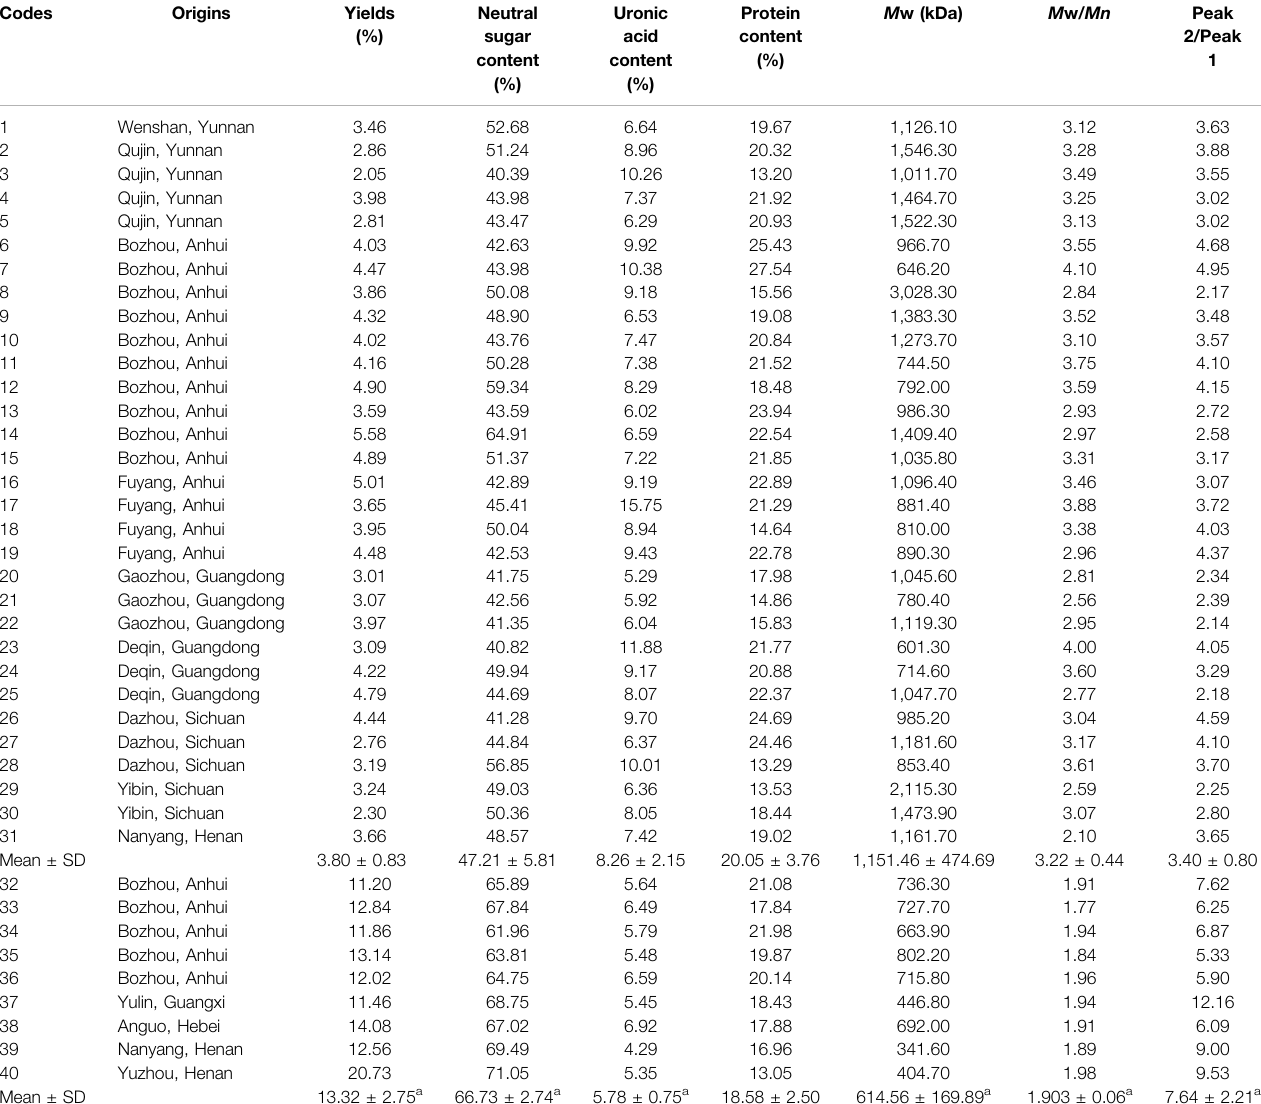
TABLE 1 | Essential information of the 40 polysaccharide samples.